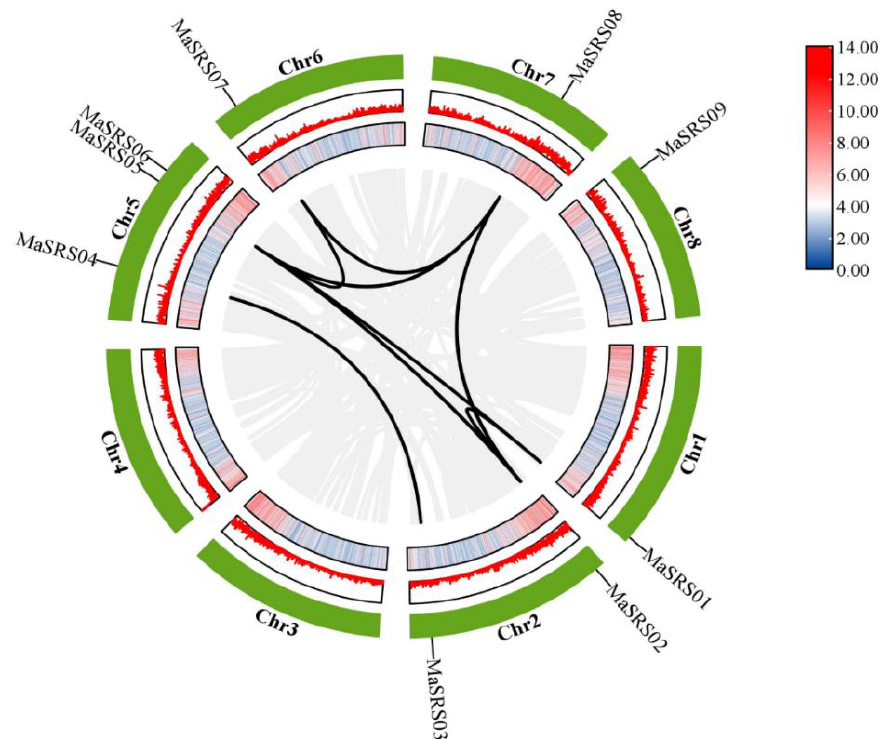
Figure 2. Gene density and synteny analysis of MaSRS genes in M. albus . Note: the eight chromosomes are shown as green partial circles at the outermost of the large circle, and the gene IDs are shown at the top of each bar. The middle and inner bars are the gene densities as a heatmap and a linear plot, respectively. The background gray lines represent all syntenic blocks of the M. albus genome, and the black lines represent duplicated MaSRS genes. The data bars color transition from blue to red which indicates that the gene distribution is denser.